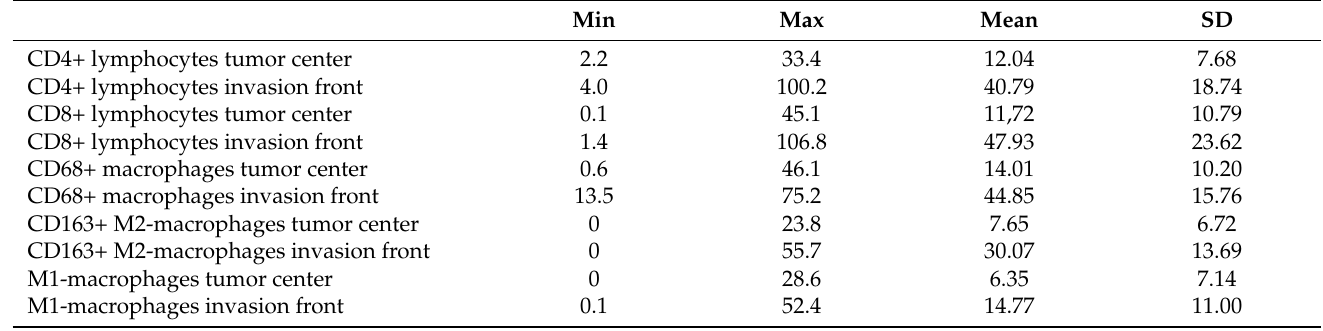
Table 2. Mean, maximum, minimum, and standard deviation of evaluated surface marker are shown. Min., minimum; Max., maximum; SD, standard